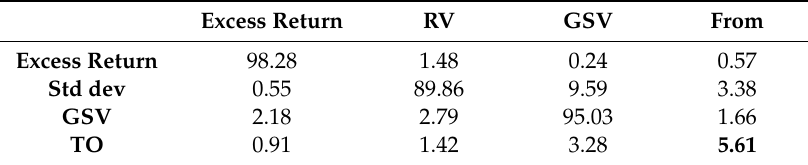
Table 7. Total spillover, Ukraine.